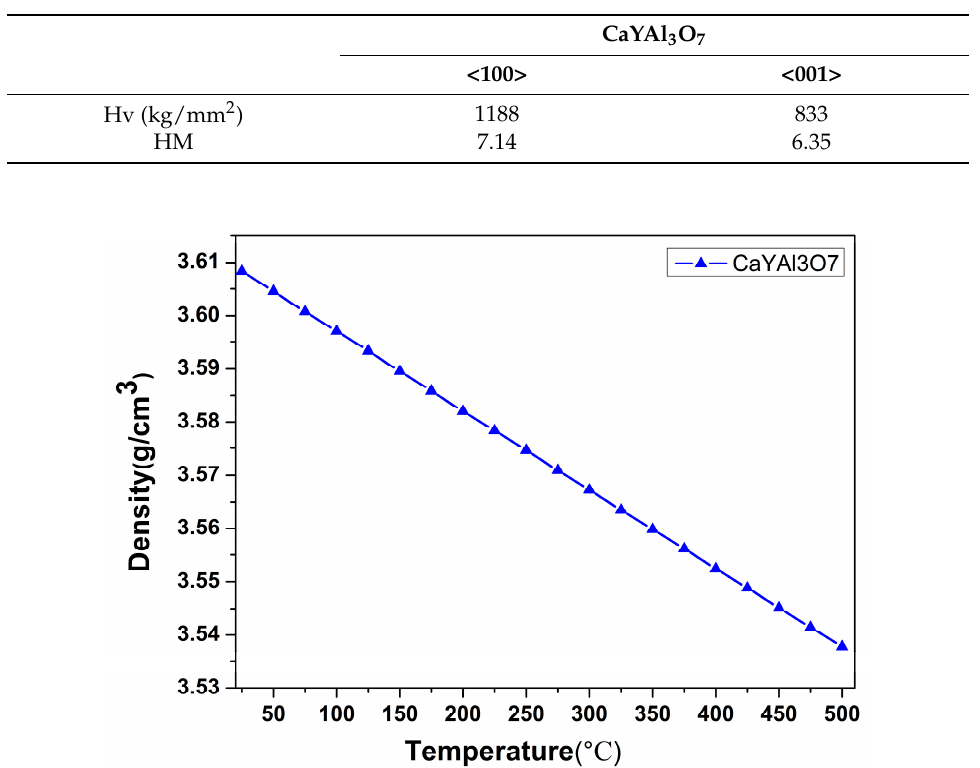
Figure 1. Density as a function of temperature for CaYAl 3 O 7 (CYAM) Figure 1 Density as a function of temperature for CaYAl 3 O 7 (CYAM) crystal.